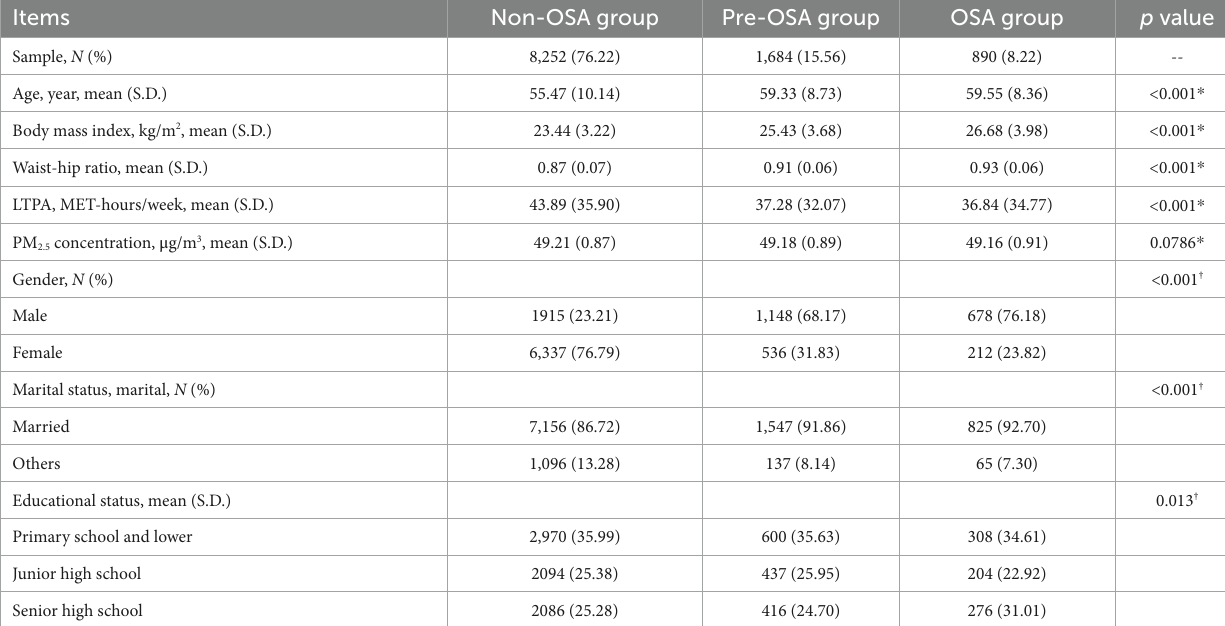
TABLE 1 Basic characteristics of the